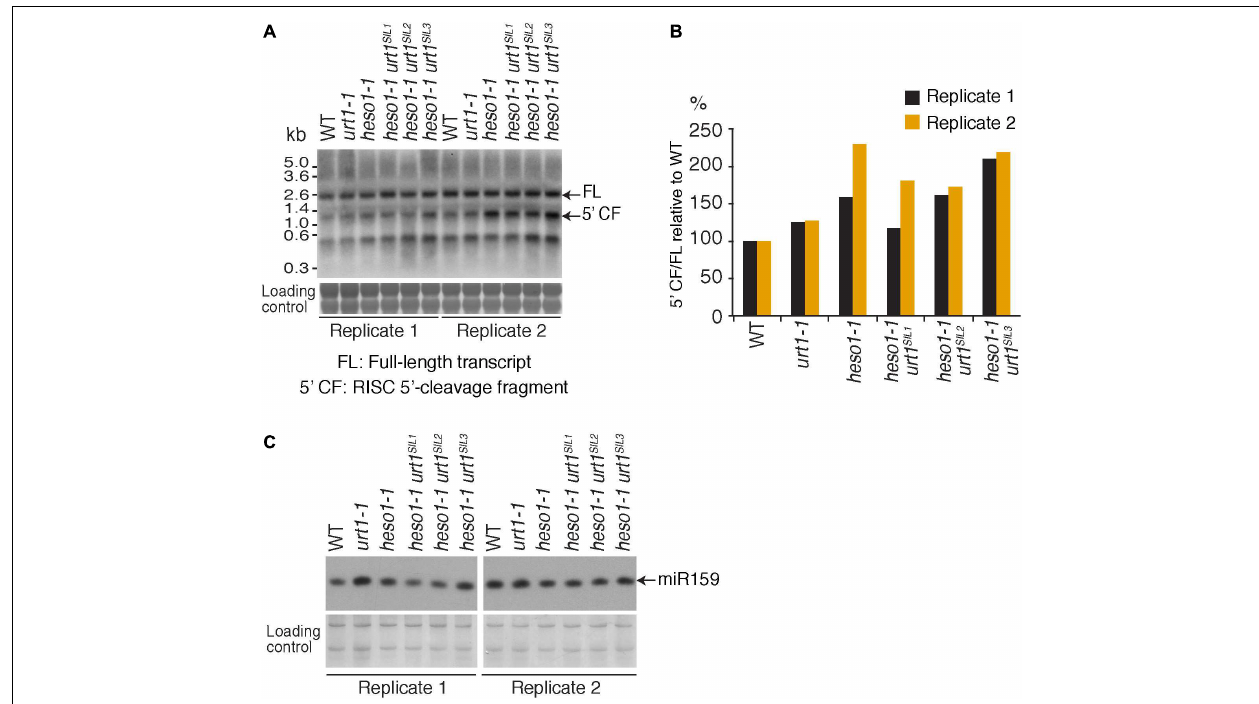
FIGURE 5 | MYB33 5 (cid:48) -cleavage fragments accumulate in heso1-1 (A) Northern blot analysis of WT, urt1-1 , and heso1-1 mutant lines using a probe 5 (cid:48) of the cleavage site to detect MYB33 full-length mRNA and the RISC 5 (cid:48) -cleavage fragment. Molecular weight markers are indicated in kb. A portion of the membrane stained with methylene blue is shown as loading control. Uncropped images are shown in Supplementary Figure S2 . (B) MYB33 RISC 5 (cid:48) -cleavage fragments accumulate mostly in the absence of HESO1. The accumulation of MYB33 RISC 5 (cid:48) -cleavage fragments (5 (cid:48) CF) relative to its full-length (FL) mRNA was determined by integrating the signals in B with a Phosphorimager. 5 (cid:48) CF/FL values for each lane were normalized to the 5 (cid:48) CF/FL ratio obtained for the WT control of each replicate. Two replicates are shown in black and orange, respectively, for WT, urt1-1 , the urt1 SIL line, heso1-1 , and the three heso1-1 urt1 SIL lines (i.e., six heso1-1 urt1 SIL samples). (C) Northern blot analysis of WT, urt1-1 , and heso1-1 mutant lines using a probe to detect miR159 . A portion of the membrane stained with methylene blue is shown as loading control. Uncropped images are shown in Supplementary Figure S2